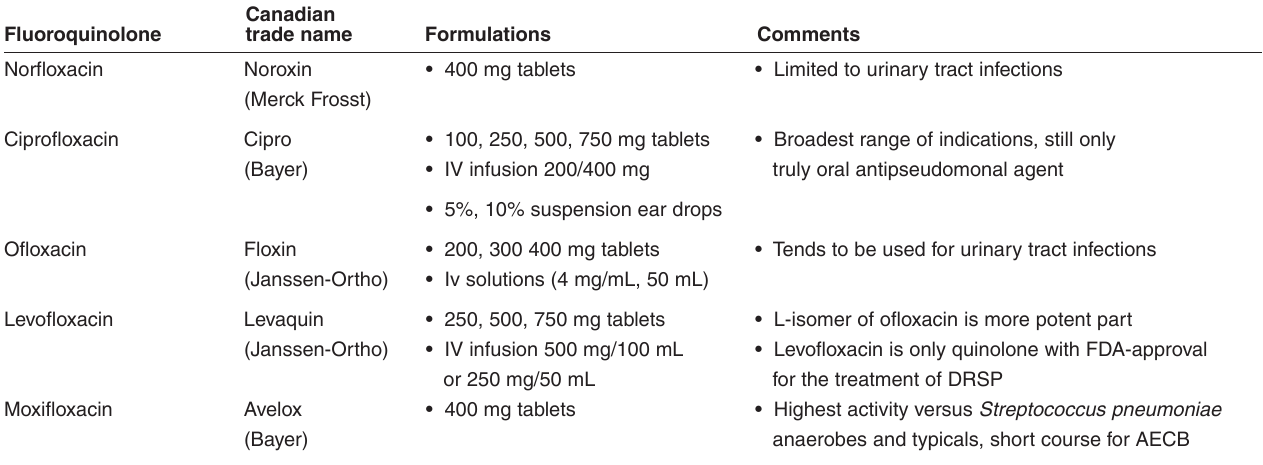
TABLE 1 Fluoroquinolones approved in Canada